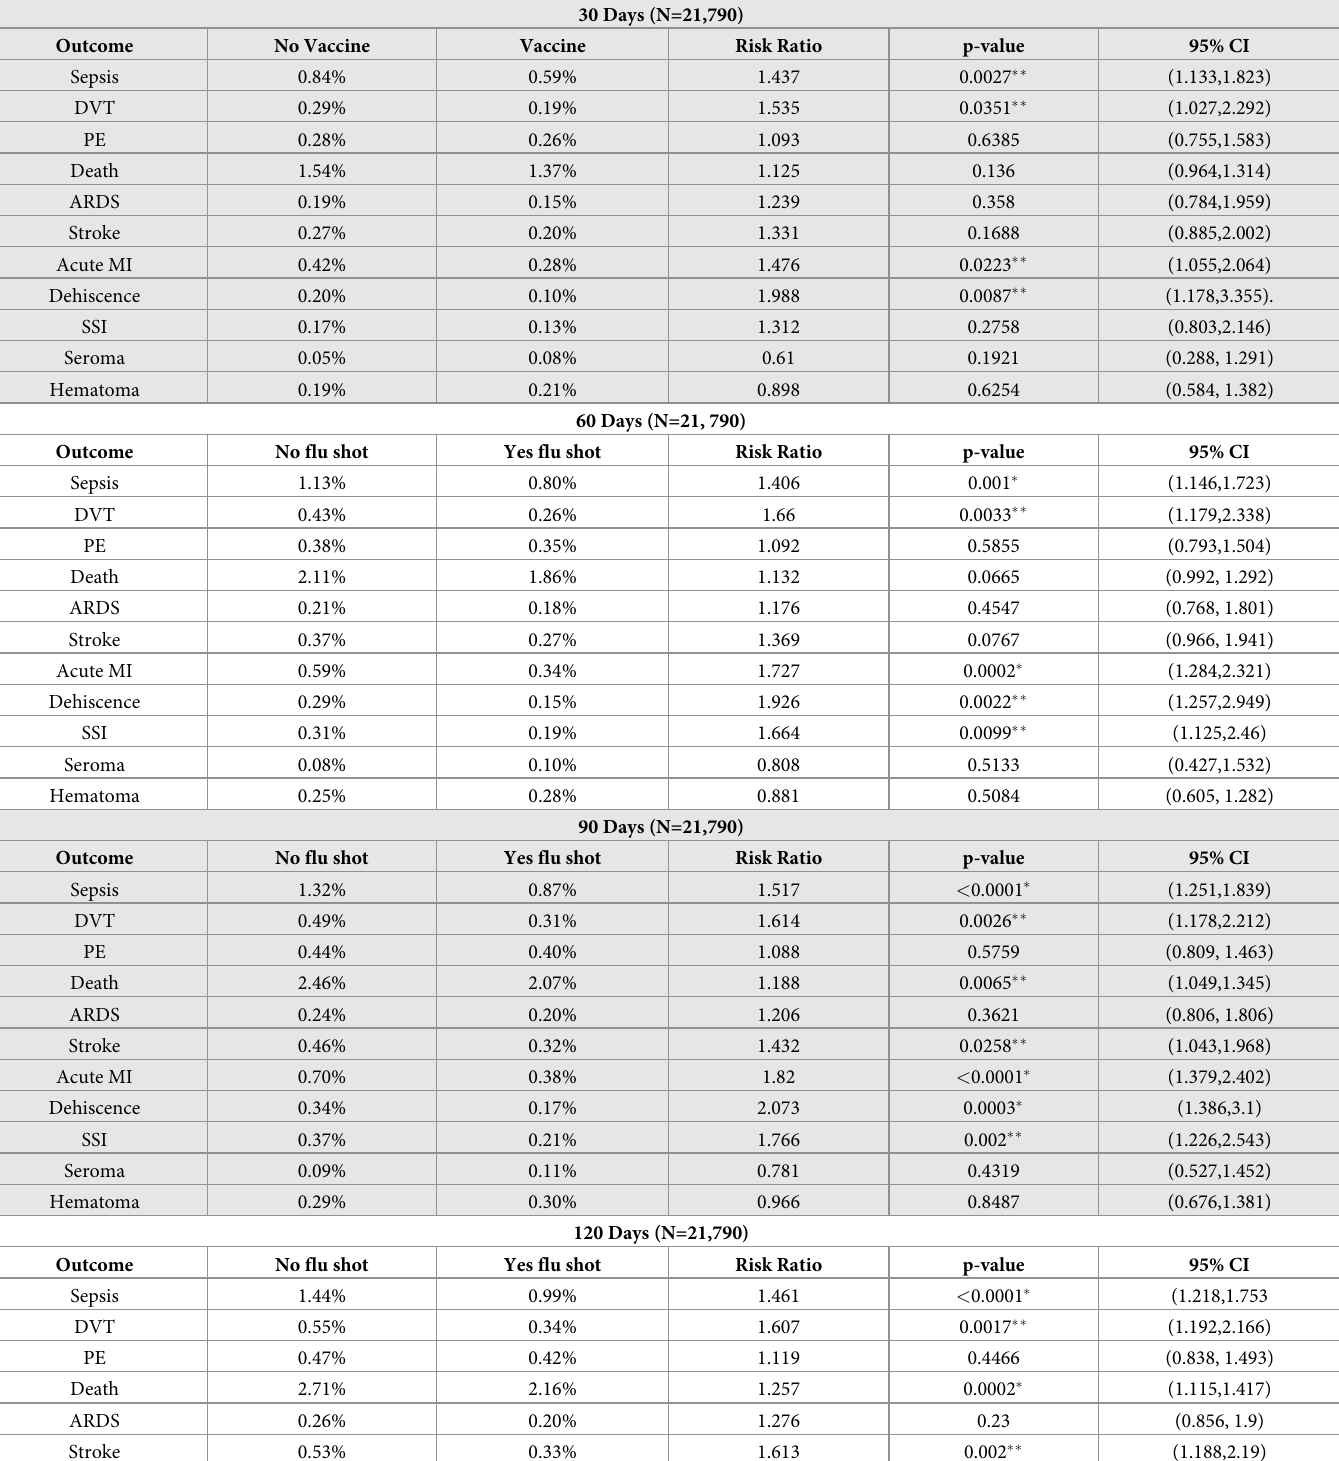
Table 3. Risks of post-operative adverse outcomes within 30, 60, 90, and 120 days of surgery in SARS-CoV-2-positive patients with or without influenza vaccination.